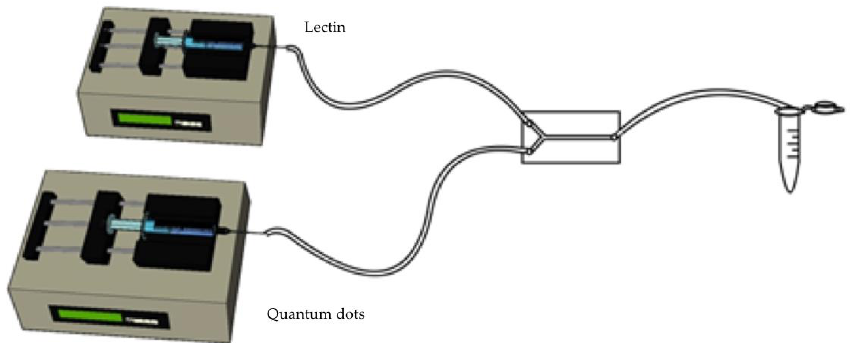
Figure 6. Diagram of the microfluidic labelling method. A lectin solution on one side, and a Quantum Dot solution on the other, both administered by infusion syringe pumps, merge in the polydimethylsiloxane (PDMS) microchip and then flow to a common pool.